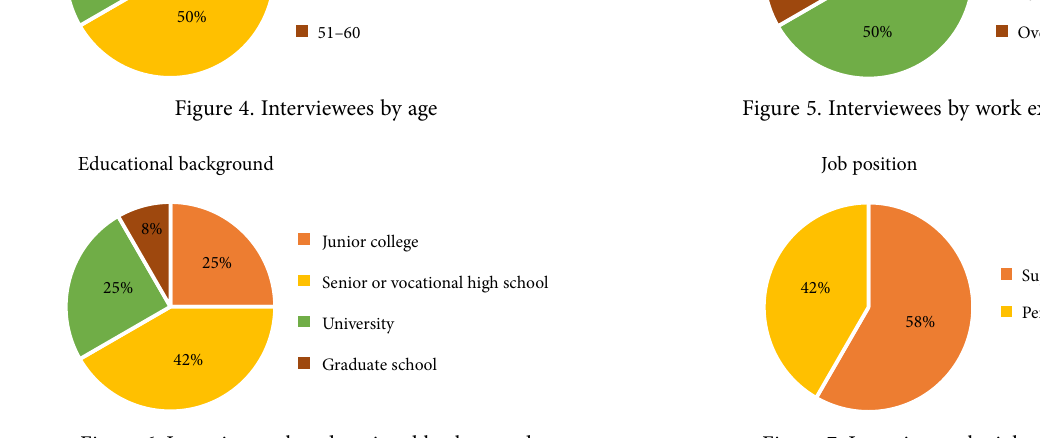
Figure 6. Interviewees by educational background Figure 7. Interviewees by job position